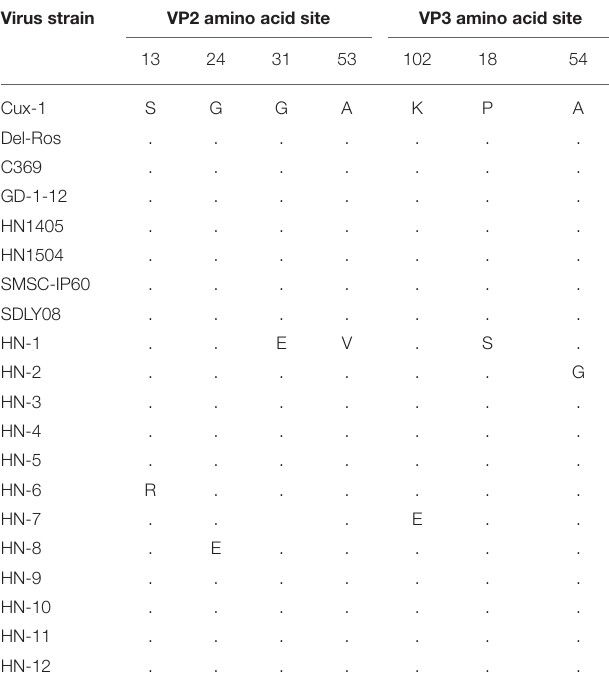
TABLE 3 | Main amino acid positions in the VP2 and VP3